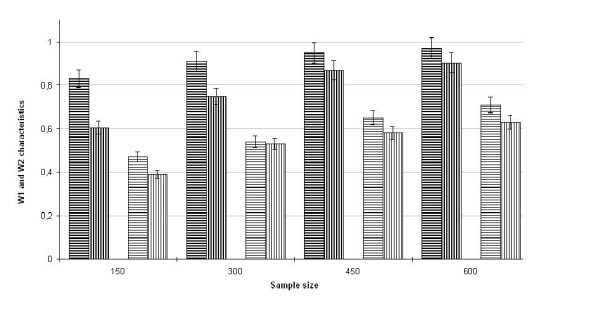
Bar graphs for W1 and W2 statistical characteristics depending on the sample size at the QTL position 5 cM. Bar graphs hatched by bold lines correspond to characteristic W1; bar graphs hatched by thin  lines correspond to characteristic W2; vertical lines are intended for the method realized by software Qxpak; horizontal lines are intended for the method proposed in this study.